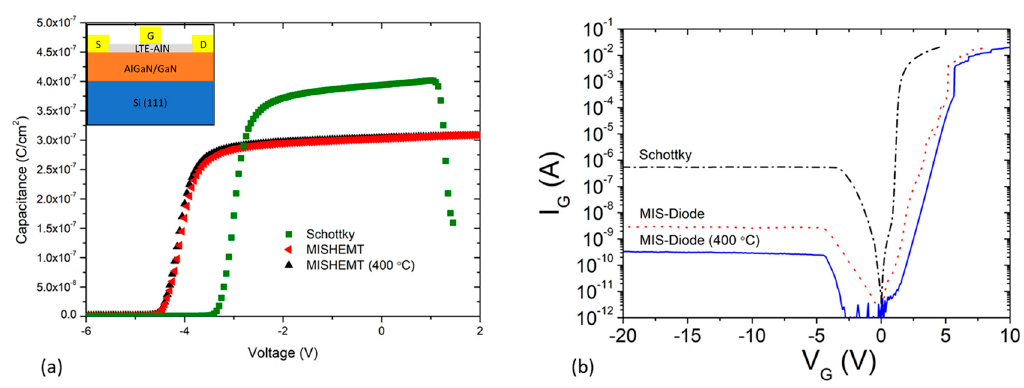
Figure 1. ( a ) C-V characteristics and ( b ) two terminal I gleak -V g (200 um diameter diodes) characteristics of Ni/AlGaN/GaN Schottky diode, as-deposited LTE-AlN/AlGaN/GaN metal-insulator-semiconductor diode [22] and post-gate annealed MIS-diode at 400 °C. Inset: Schematic cross-sectional diagram of fabricated AlGaN/GaN MISHEMTs with LTE grown AlN on Si substrate.